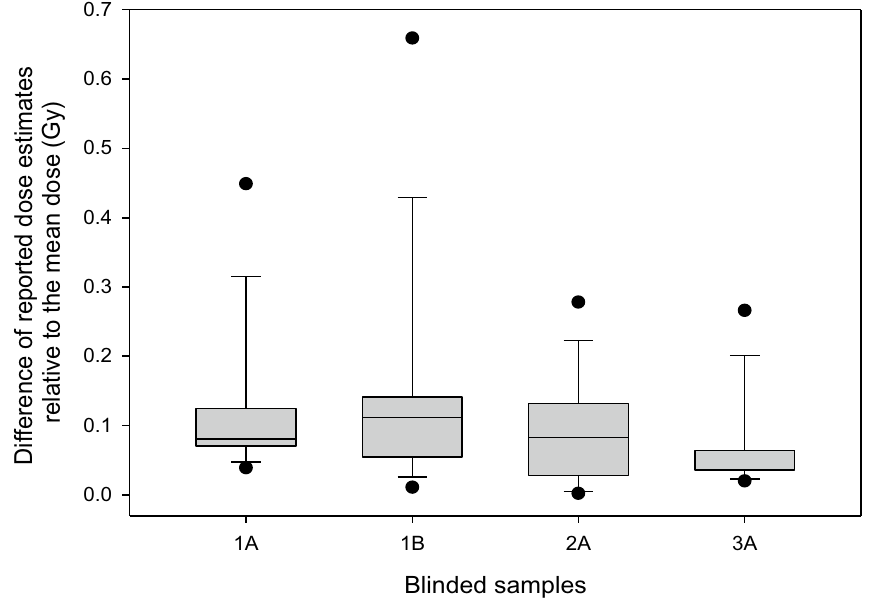
Figure 4. The box plot reflects the absolute difference of all reported dose estimates from all teams relative to the mean reported dose value per blind sample. The box plot shows the 10th (lower whisker), 25th (lower end of the box), 50th (median, straight line), 75th (upper end of the box) and 90th (upper whisker) percentiles (graph created using SigmaPlot Version 14.0, http:// www. systa tsoft ware.